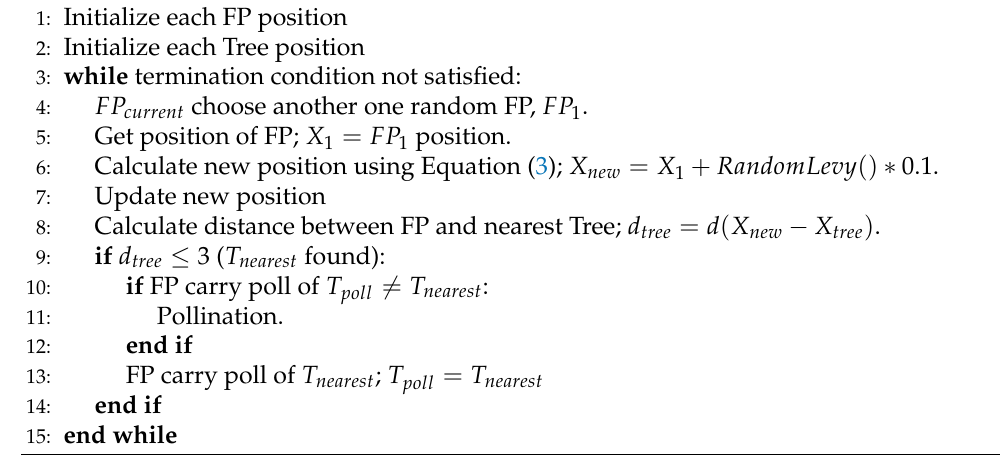
Algorithm 3 The Idle-Cuckoo Search via Lévy Flights